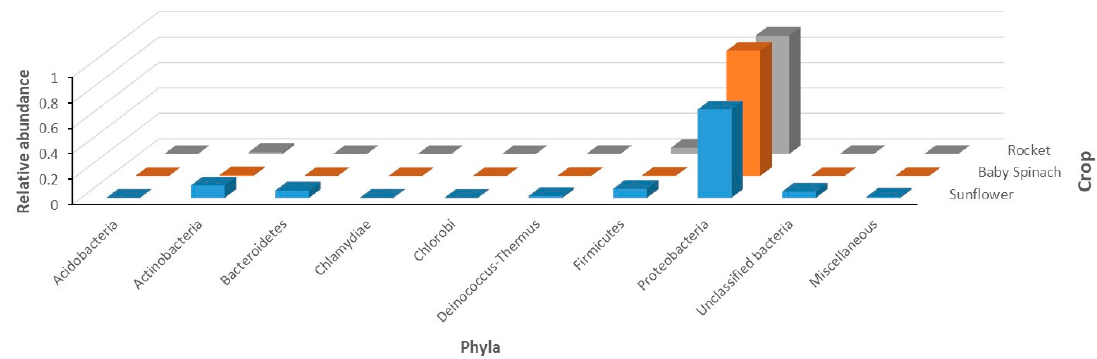
Figure 2. Bacterial phyllosphere community structure of some greenhouse crops artificially illuminated with high-pressure sodium lamps (HPS). Blue: sunflower, Helianthus annuus L. [51]. Orange: baby leaf spinach ( Spinacia oleacea) ; grey: rocket ( Diplotaxis tenuifolia) [Alsanius, unpublished data]. ( Illustration: B. Alsanius ).